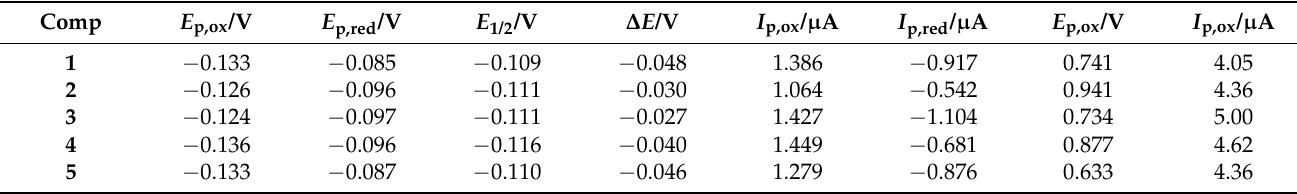
Figure 8. Cyclic voltammograms of 1 – 5 (c(complex) = 10 − 4 M) in 0.1 M NaCl measured at BDD electrode using scan rate of 100 mV/s. Table 5. Redox parameters of 1 – 5 extracted from experimental CV data.